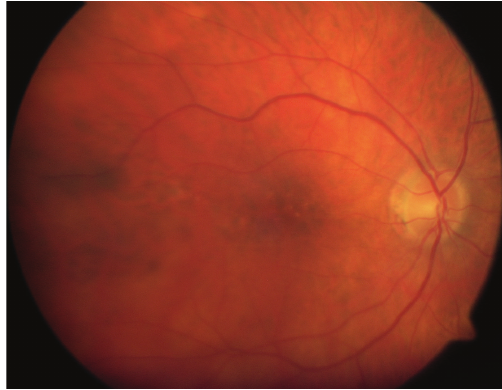
Figure 2: Fundus photograph showing macular scarring and peripheral chorioretinal changes.This was seen in all the three